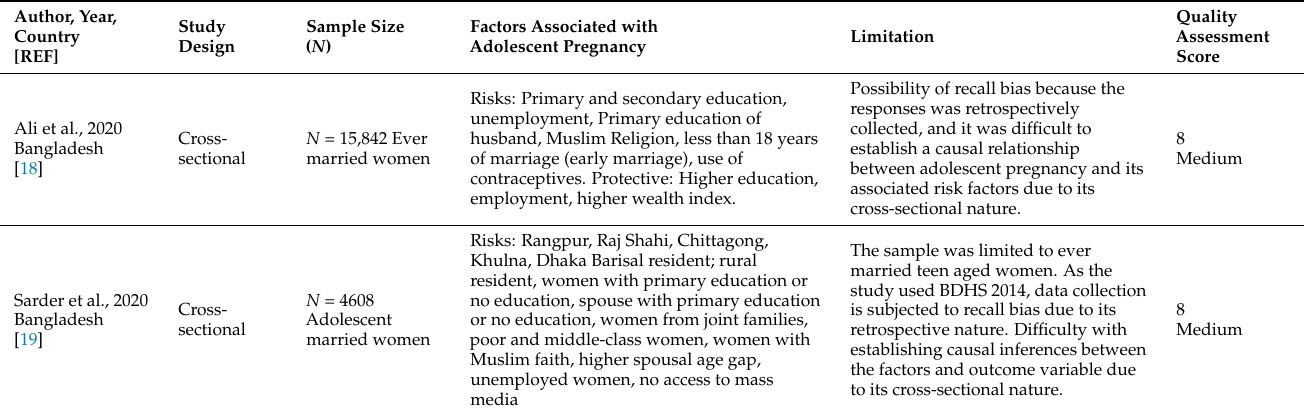
Table 1. Summary of the selected